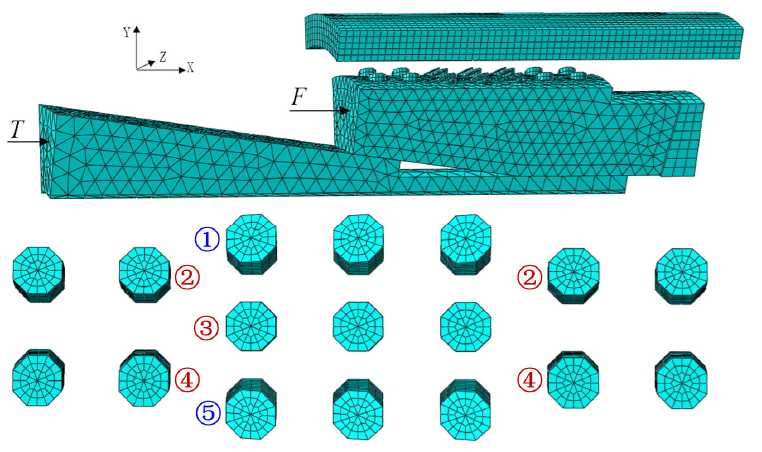
Figure 5. Finite element model.